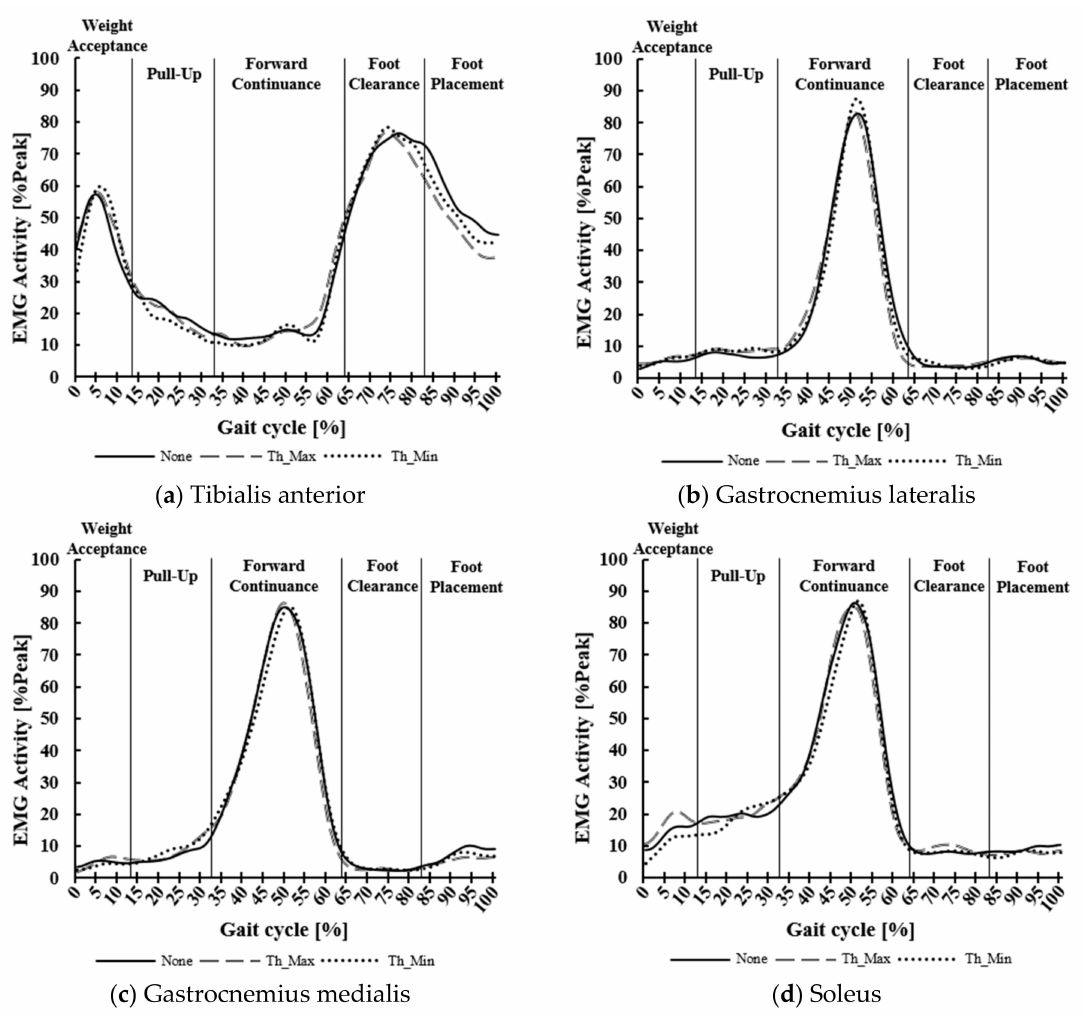
Figure 2. Mean of electromyogram (EMG) activity of all participants in the vibrational stimulation conditions at the threshold intensity: ( a ) Tibialis Anterior (TA), ( b ) Gastrocnemius Lateralis (GL), ( c ) Gastrocnemius Medialis (GM), ( d ) Soleus (SOL). ‘Th-Max’ means a vibration of 140 Hz was applied at the threshold intensity, while ‘Th-Min’ means a vibration of 210 Hz was applied at the threshold intensity. The solid line indicates the gait phase (Weight Acceptance (WA, 0%~14%), Pull-Up (PU, 15%~32%), Forward Continuance (FCN, 33%~64%), Foot Clearance (FC, 65%~82%), Foot Placement (FP,